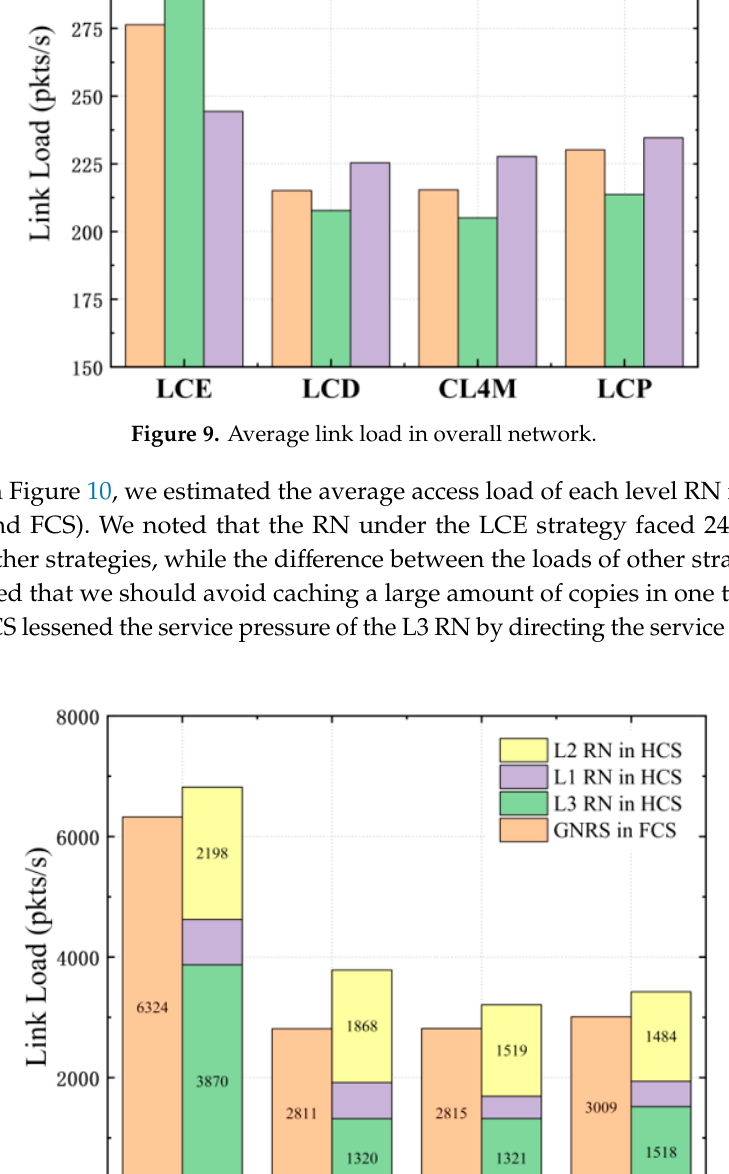
Table 2. Flow rules were configured and installed on the forward core of the router in